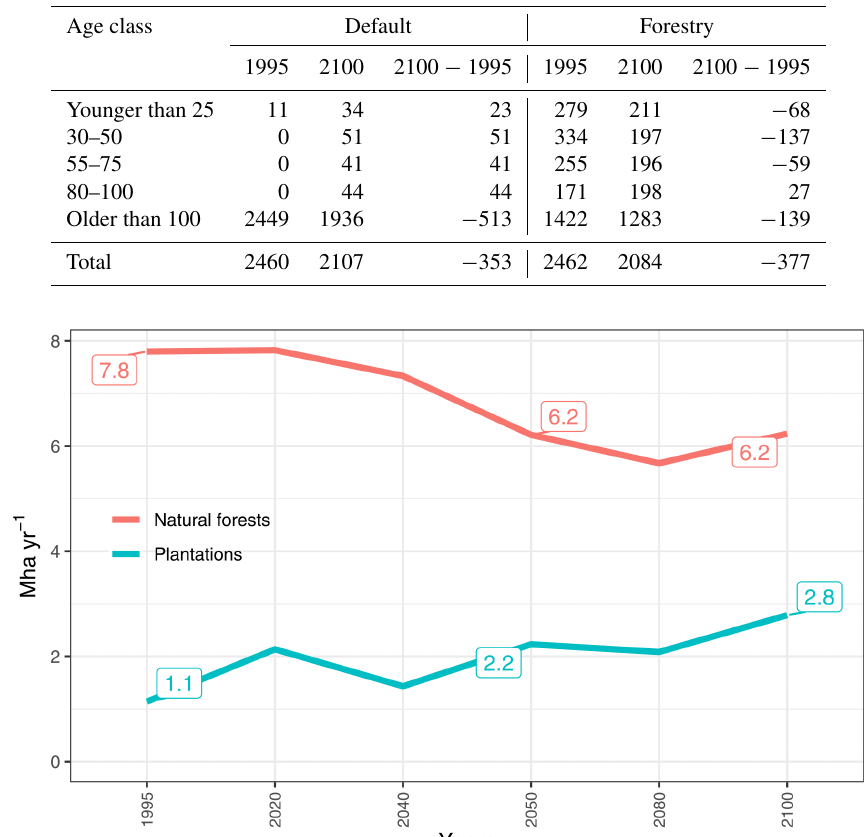
Figure 16. Global annual area harvested for roundwood production (in Mhayr − 1 ) by source in the forestry scenario.